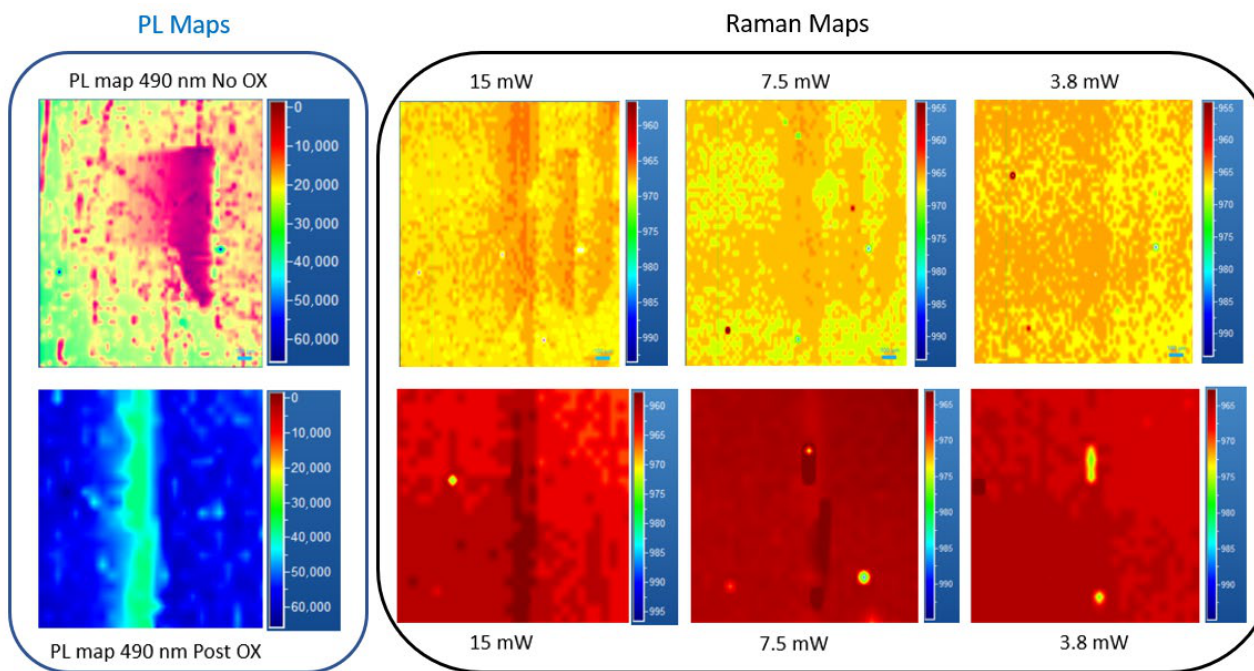
Figure 7. PL and Raman maps of an isolated defect at 490 nm No_Ox (upper strip) and Post OX (lower strip) for different induced carrier values related to the laser power used (15–7.5–3.8 mW, respectively) following the LO peak position .